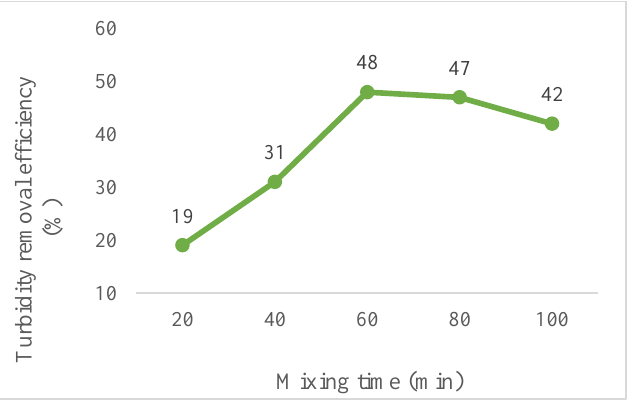
Fig. 3. Effect of mixing time on turbidity removal